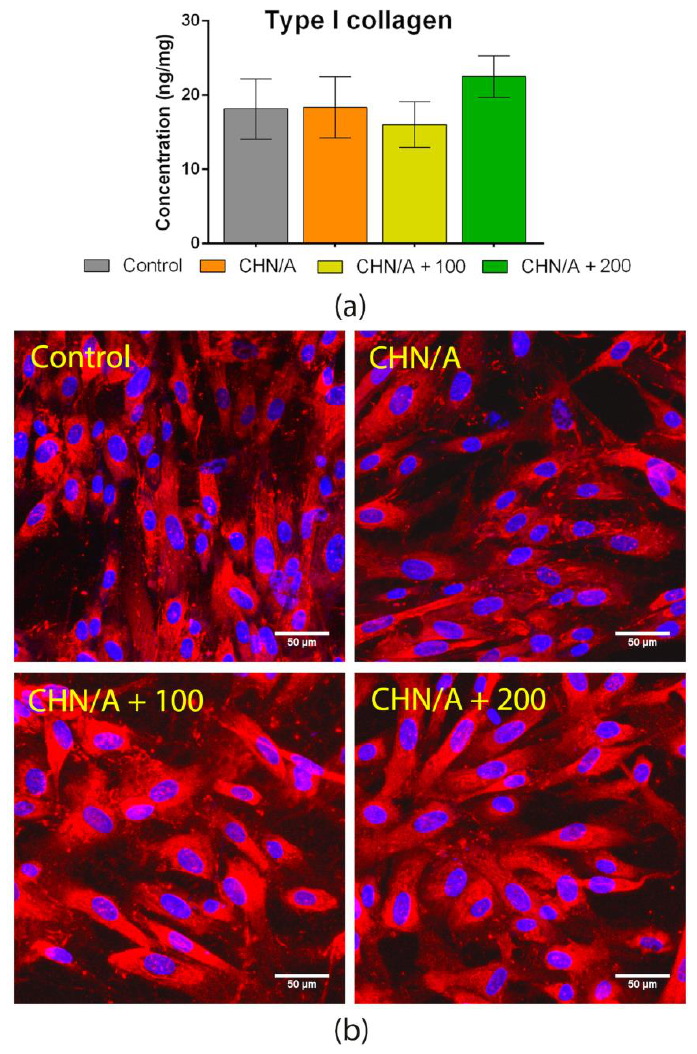
Figure 9. Type I collagen synthesis: ( a ) ELISA detection of the collagen in the cell lysates obtained after 5-day culture on the insert membranes in the presence of biomaterials; ( b ) Visualization of collagen deposited in the 5-day fibroblast culture that was performed on the insert membrane; immunofluorescent staining (type I collagen—red fluorescence, nuclei—blue